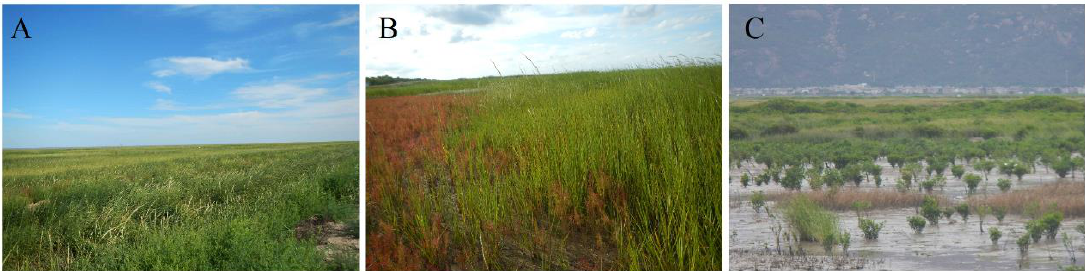
Figure 8. Photos indicating negative effects of invasive S. alterniflora : ( A ) affecting foraging habitats of water birds, ( B ) invasion upon native Suaeda heteroptera and ( C ) mangroves; all the photos were taken in 2016.